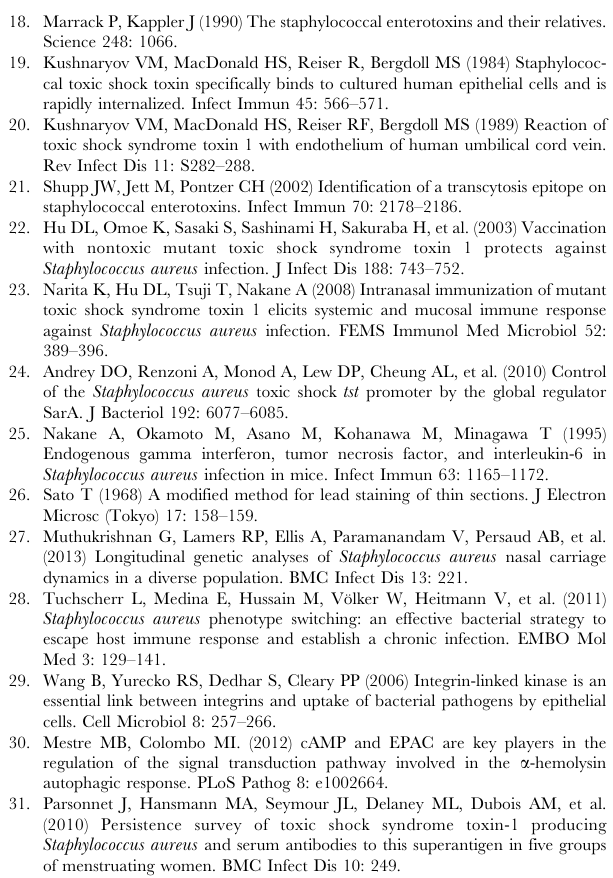
Figure S7 Effect of TSST-1 on invasion assay at MOI 100 in the presence of rTSST-1. (TIF) Figure S8 TSST-1-producing S. aureus suppresses au- tophagy in HEK293 and 407 cells. (TIF) Figure S9 LC3-II accumulation in the D tst -infected cells was reduced by addition of rTSST-1. (TIF) File S1 Supporting information describing methodolo- gies and results of Lysotracker-stained lysosomes, tst mutant construction and effect of TSST-1 on adhesion and invasion assay of S. aureus